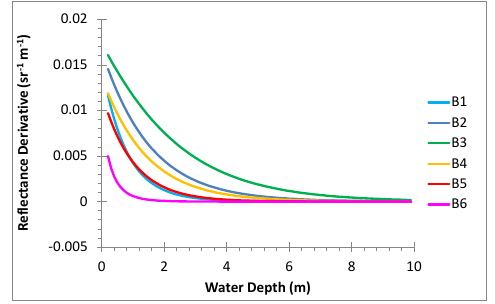
Figure 4. Derivative of reflectance with respect to water depth for the first 6 spectral bands of WorldView-2 for coastal sea water with a dark seabed.